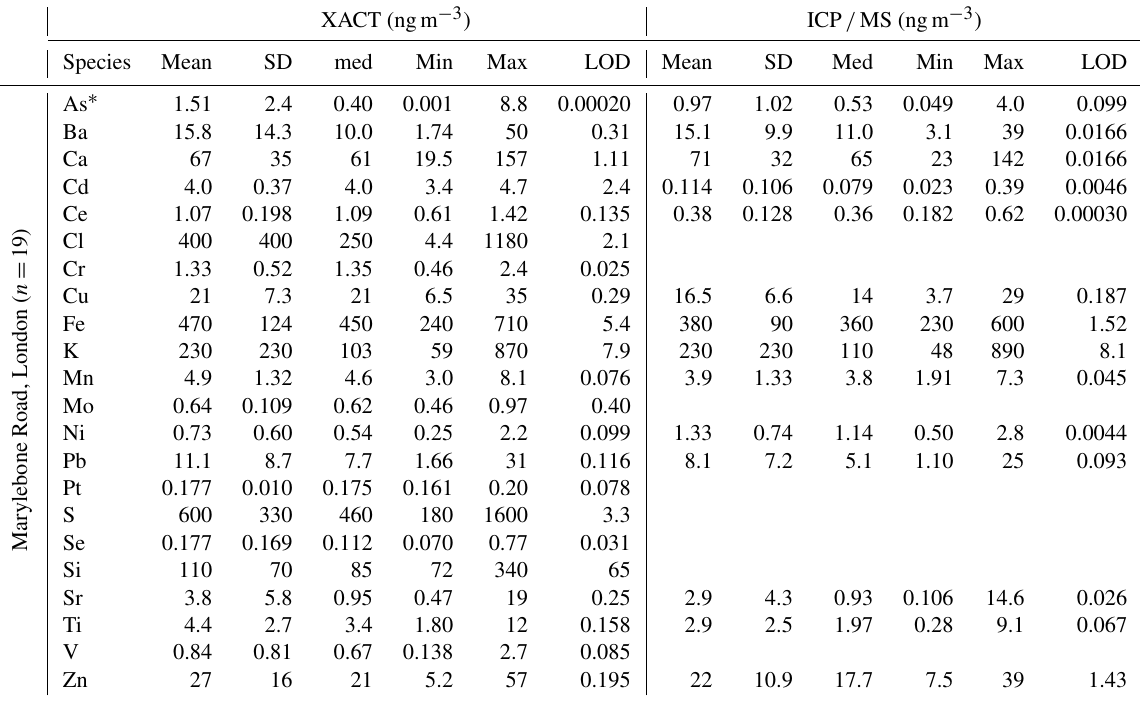
Table 3. Overview of Marylebone Road, London measurements by XACT and ICP-MS (ngm − 3 ). The asterisk ( ∗ ) denotes that only 18 samples were collected for XACT As).